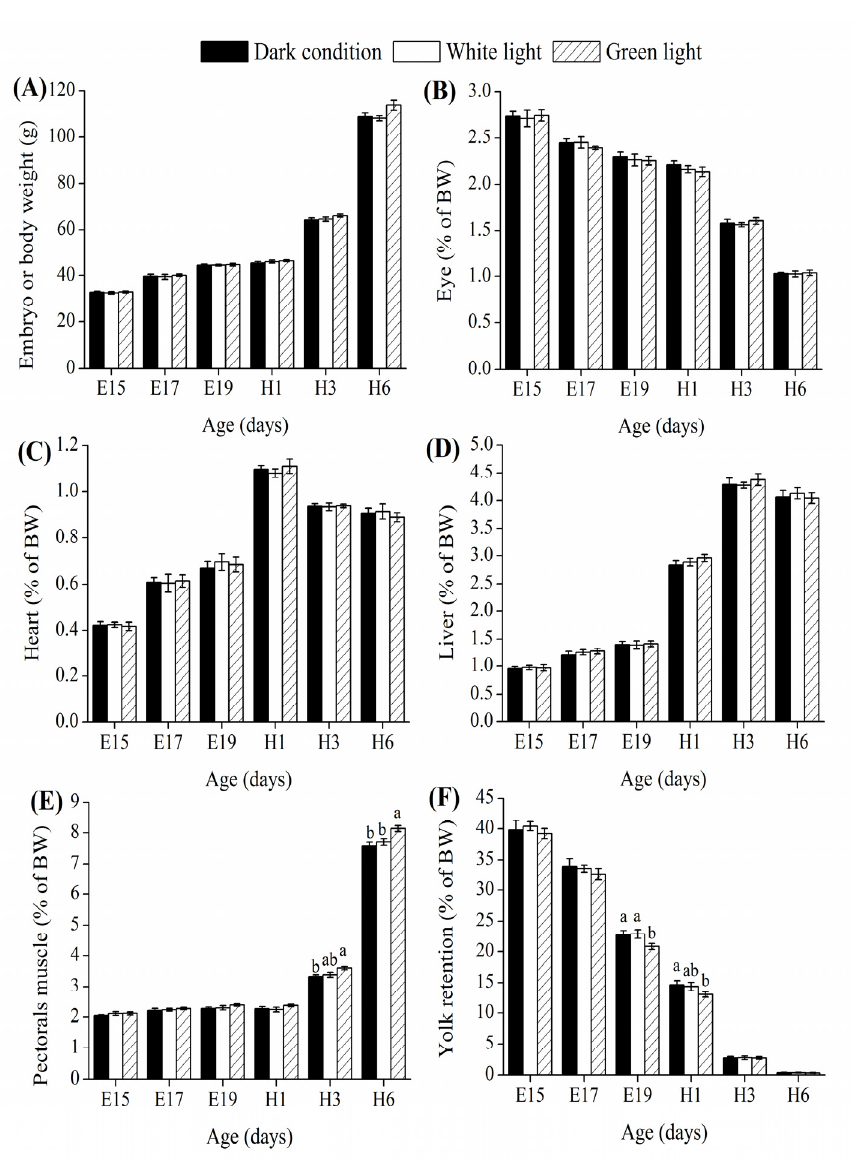
Figure 4. Chick (A) embryo (with yolk body mass) or body weight, (B) eye, (C) heart, (D) liver, (E) pectorals muscle, and (F) yolk retention weight percentage of body weight (BW) of chick embryos on embryonic days 15, 17, and 19 (E15, E17, and E19) and newly hatched chicks on posthatch days 1, 3, and 6 (H1, H3, and H6) incubated under light-emitting diodes–based white light, green light or dark condition. Values are presented as means±standard error (n = 8). Bars with different letters indicate significant differences between treatments at the same age